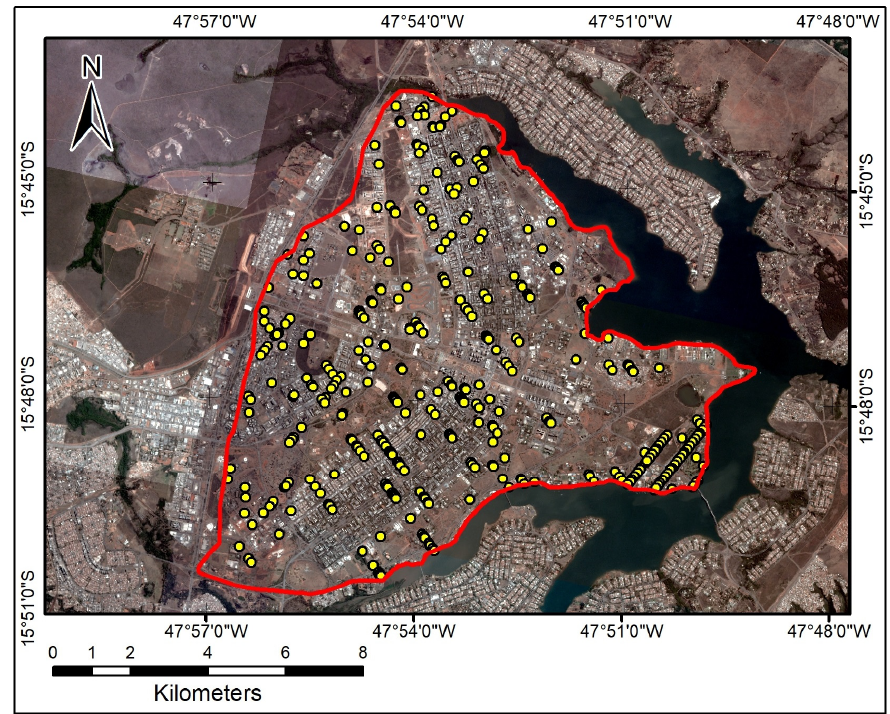
Figure 7. Location of the GEDI samples excluded from <100 to <3 m thresholds. The yellow dots are the GEDI samples.